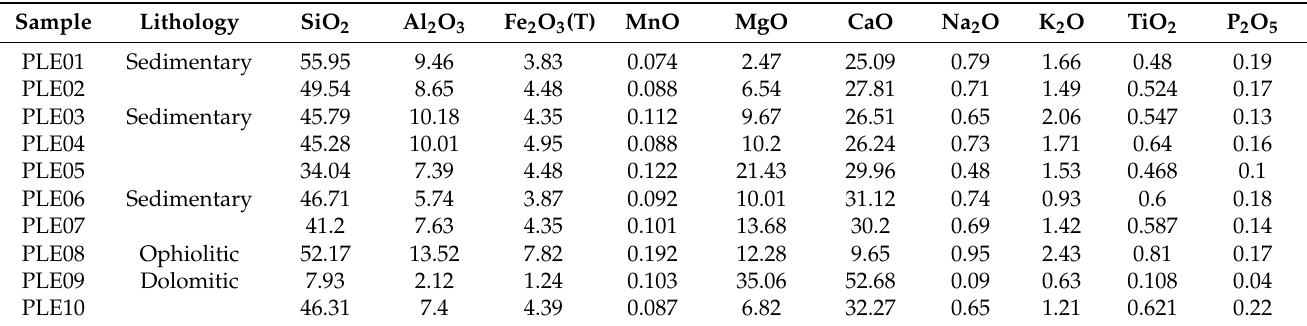
Table 2. Content of oxides (%).